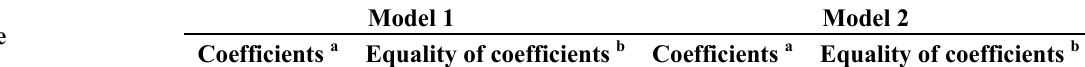
Table 4. Effect of single and multiple events on EQ-5D score: results from the UK tariff.